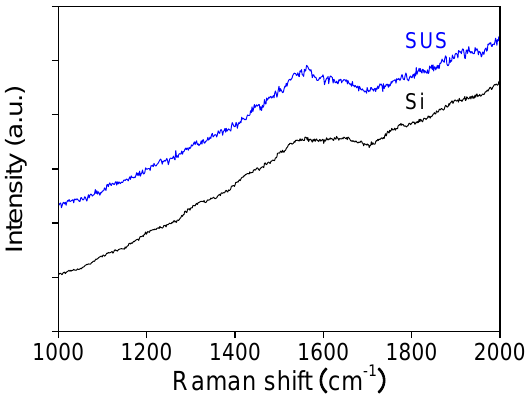
Figure 7. Raman spectrum of a-C:H film deposited at a trench depth of 2 mm for both Si and SUS430 substrates (condition A, a-C:H deposition using Toluene only).